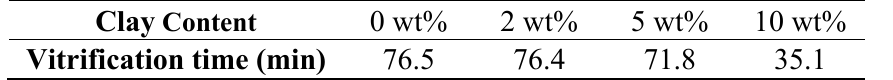
Table 2. Vitrification time for the different clay contents during isothermal cure at 50 °C.